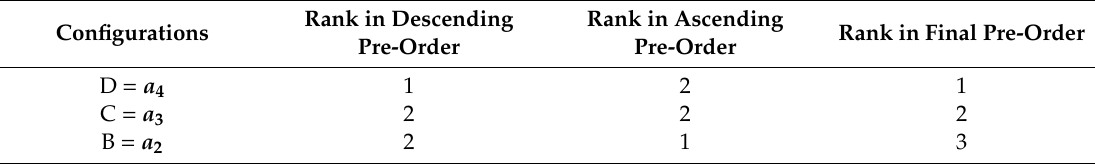
Table 15. Ranking results.